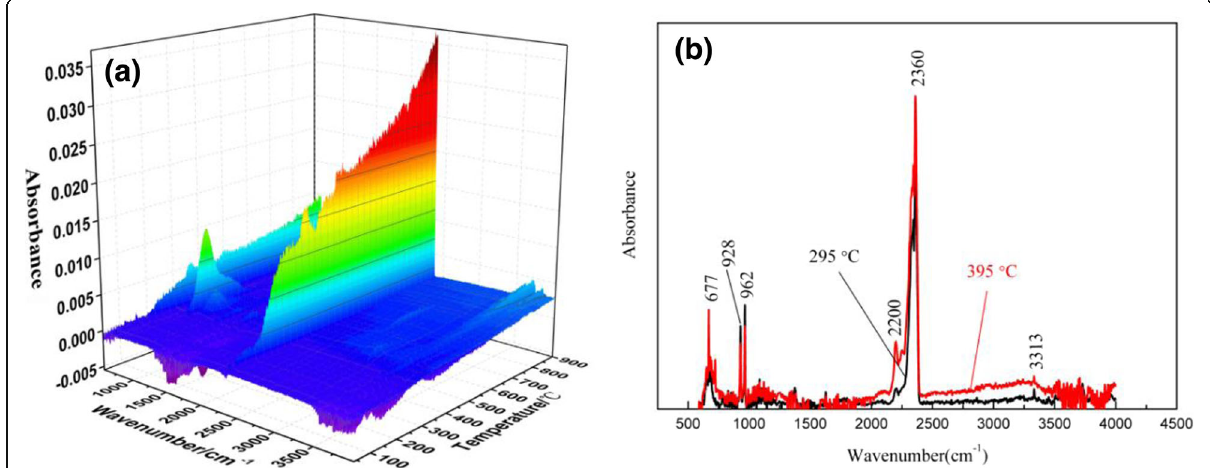
Fig. 10 ( a ) 3D plots of FTIR spectra of evolved gases in the decomposition of VLF in nitrogen atmosphere, ( b ) FTIR spectra of evolved gases